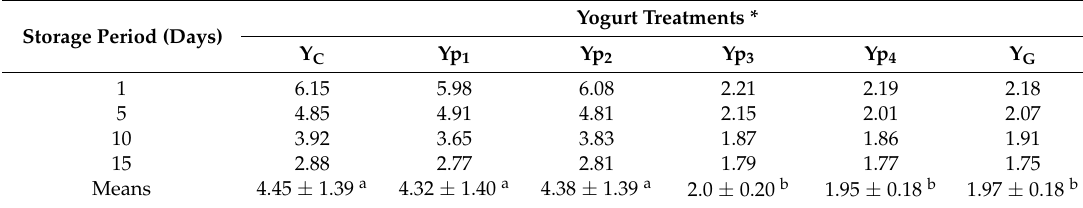
Table 6. Mean values of syneresis (g/100 g) in yogurt